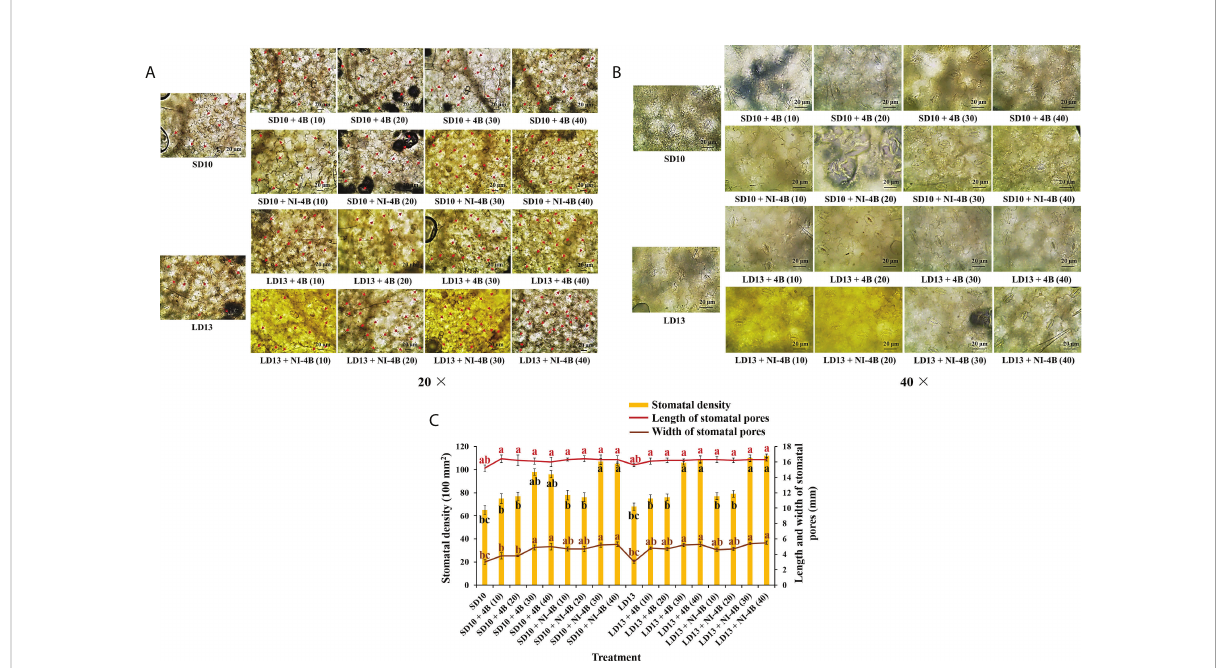
FIGURE 3 The stomatal traits of chrysanthemum ‘ Gaya Glory ’ under different intensities of supplemental or night-interruptional blue light, after 60 days of exposure to the photoperiodic light treatments: the micrographs of stomatal density (magni fi cation 20×) (A) and speci fi c state of stomatal pores (magni fi cation 40×) (B) ; the analysis chart (C) of stomatal density and pores. The red arrows indicate the locations of stomata in Figure (A) Bars indicate 20 m m in Figures A and (B) Vertical bars indicate the means ± standard error (n = 6). Different lowercase letters indicate signi fi cant separation within treatments by Duncan ’ s multiple range test at p ≤ 0.05. See Figure 1 for details of photoperiodic light treatments with blue